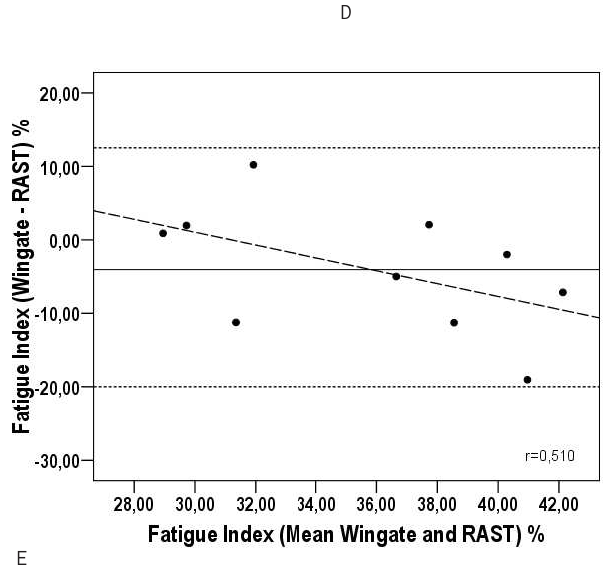
Figure 1. Bias plotting (mean differences) between Wingate test and RAST, respectively for: peak power, A (W.kg -1 ) and B (W), mean power, C (W.kg -1 ) and D (W) and fatigue index, E (%), according to procedures by Bland-Altman